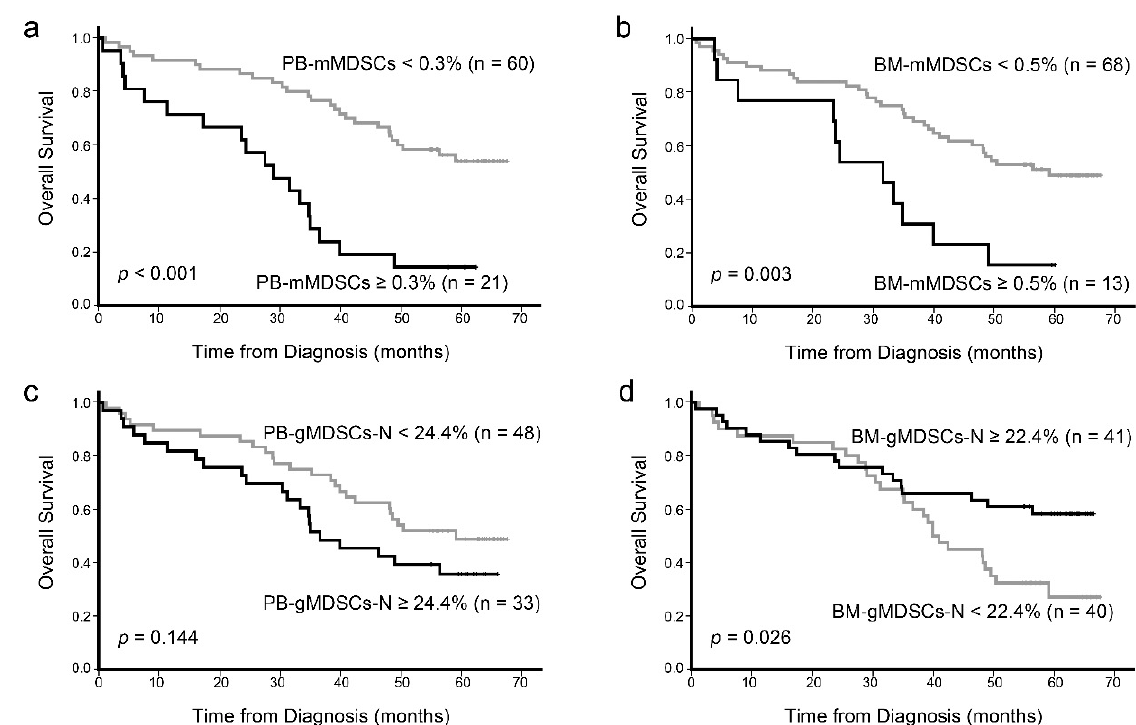
Figure 5. Kaplan–Meier survival curves for overall survival in 81 patients with plasma cell myeloma in which patient groups were categorized based on the proportion of four types of myeloid-derived suppressor cells measured at diagnosis. Patients with PB-mMDSCs ≥ 0.3% and BM-mMDSCs ≥ 0.5% showed worse OS than the patients with PB-mMDSCs < 0.3% and BM-mMDSCs < 0.5%, respectively ( p < 0.001 and p = 0.003) ( a , b ). PB-gMDSCs-N ≥ 24.4% showed a trend for worse OS compared to that of PB-gMDSCs-N < 24.4%, but it was not significant (p = 0.144) ( c ). BM-gMDSCs-N ≥ 22.4% was associated with better OS than BM-gMDSCs-N < 22.4% ( p = 0.026), but the survival curves of the two groups overlapped until the mid-point of observation time (35 months from diagnosis) ( d ).Abbreviations: OS, Overall survival; PB-mMDSCs, peripheral blood monocytic myeloid-derived suppressor cells; BM-mMDSCs, bone marrow monocytic myeloid-derived suppressor cells; PB-gMDSCs-N, peripheral blood granulocytic myeloid-derived suppressor cells with neutrophils; BM-gMDSCs-N, bone marrow granulocytic myeloid-derived suppressor cells with neutrophils.